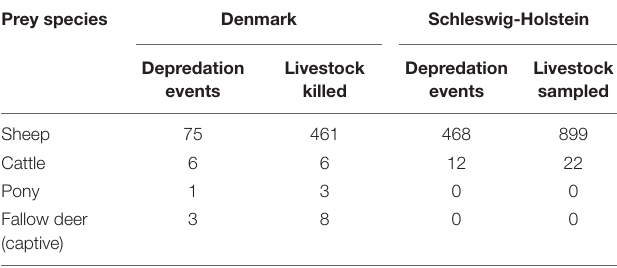
TABLE 1 | The number of confirmed livestock depredation events and number of individuals killed (Denmark) or sampled (Schleswig-Holstein) by wolves between 2012 and 2021.